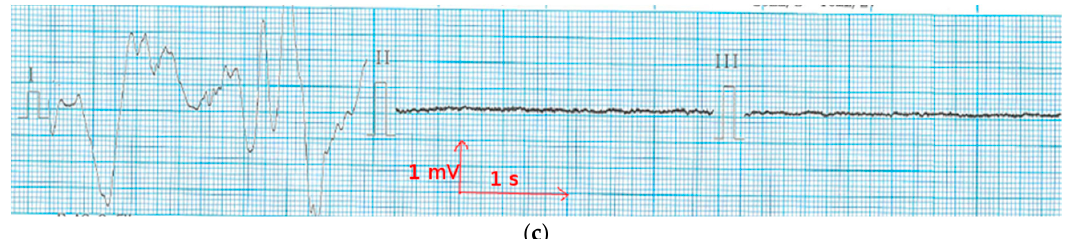
Figure 9. Electrocardiography from the cotton electrodes after 50 washing cycles ( a ) at rest; ( b ) when walking, and ( c ) when climbing stairs.